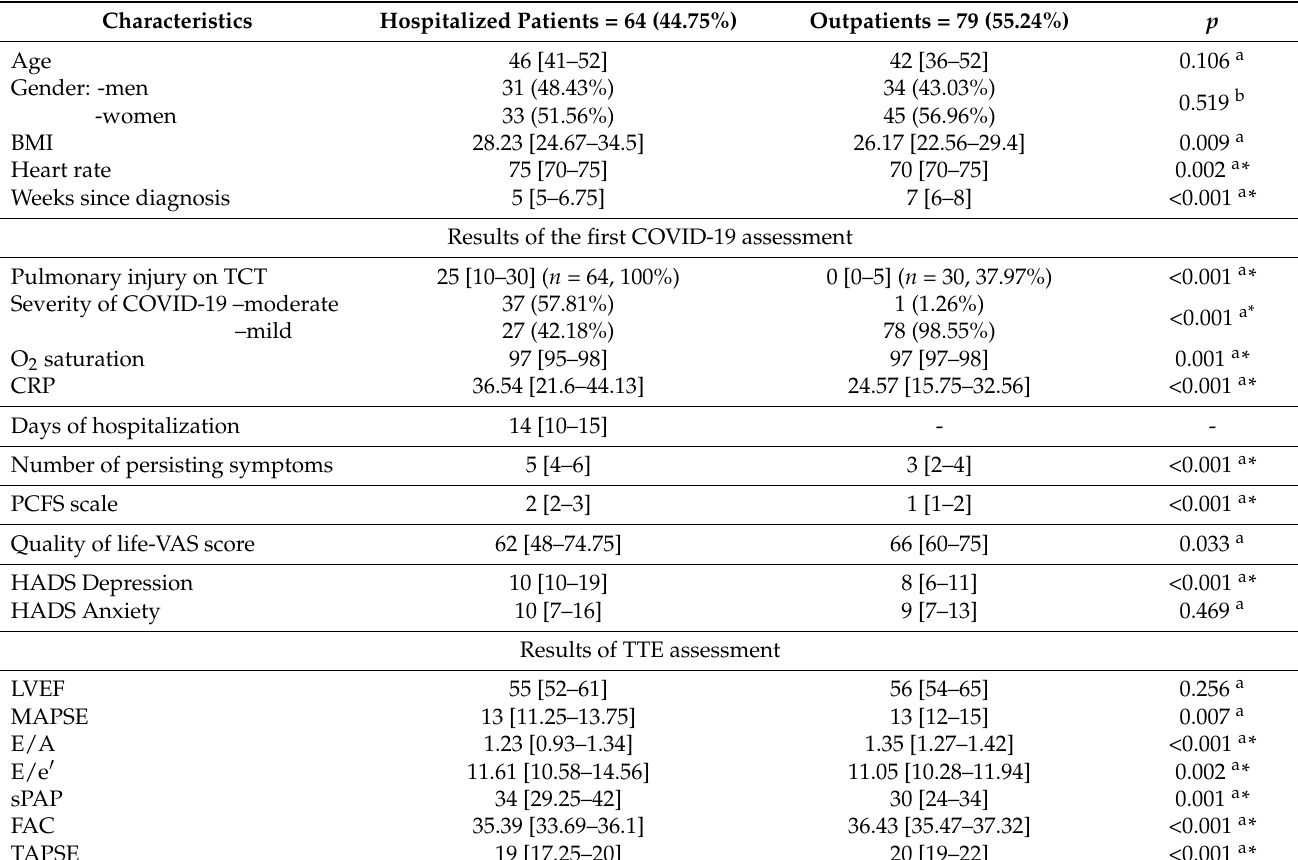
Table 1. Characteristics of study